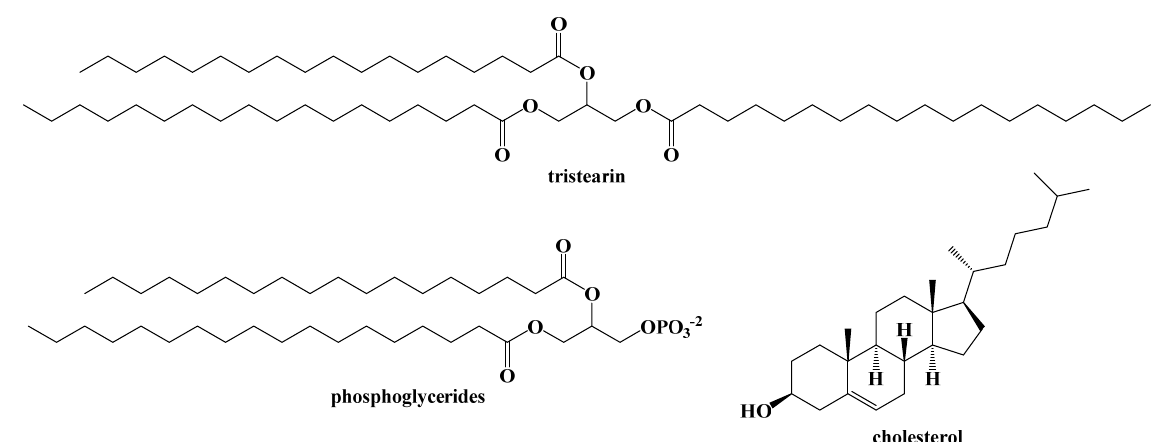
Figure 5. Examples of Common Dietary Fats.